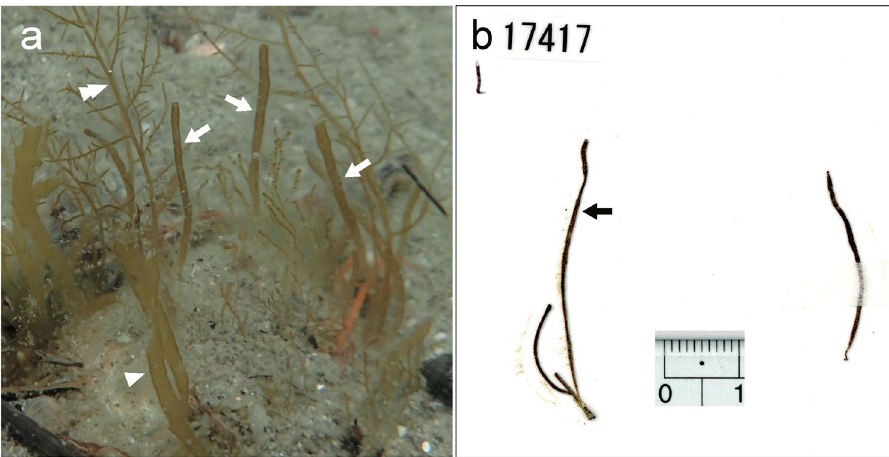
Figure 1. Habit and type specimen of Setoutiphycus delamareoides gen. & sp. nov. (Suo-Oshima, 12 April 2017). ( a) Underwater photograph showing habit of S. delamareoides (arrows) growing mixed with Acrothrix gracilis (double arrowhead) and Striaria attenuata (arrowhead). ( b) Holotype specimen (arrow; SAP115639; silica gel dried specimen housed as KU-d17417). [Photographs by H.